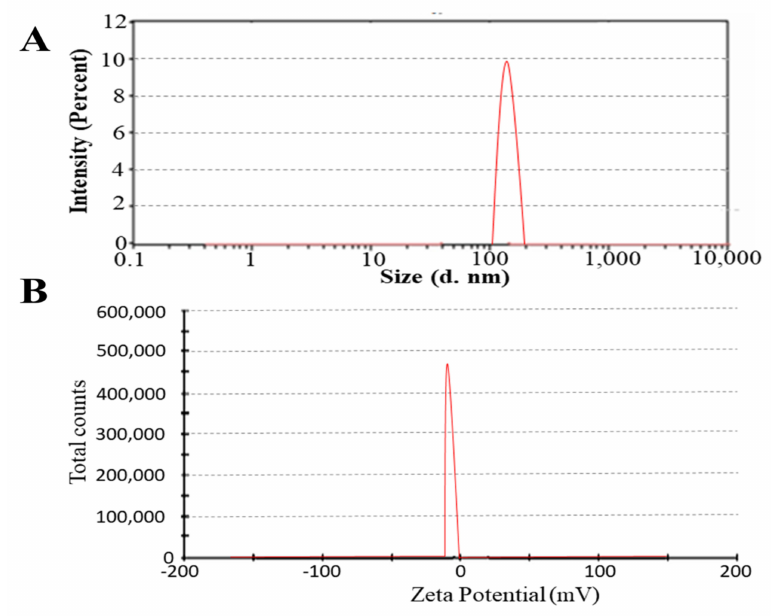
Figure 1. PS ( A ) and ZP ( B ) of optimum formulation FN7 showed a particle size of 110 nm and a ZP value of −